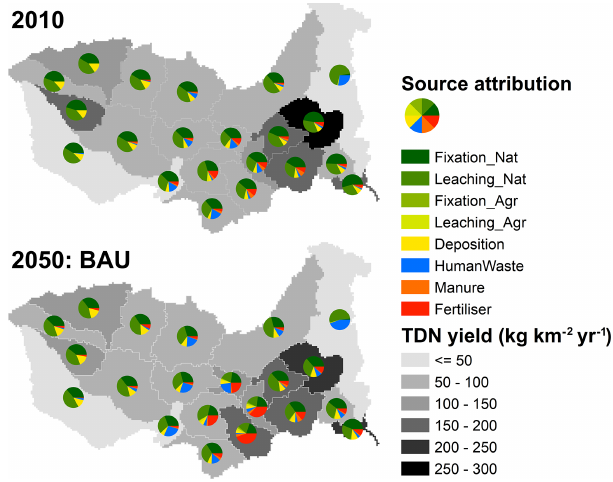
Figure 16. Increase in river export of total dissolved nitrogen to sea between 2010 and 2050 (business-as-usual scenario).